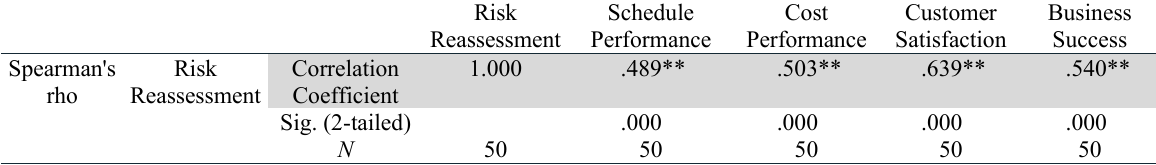
Correlations: Risk Reassessment and Project Success Outcomes (Schedule Performance, Cost Performance, Customer Satisfaction, and Business Success) Risk